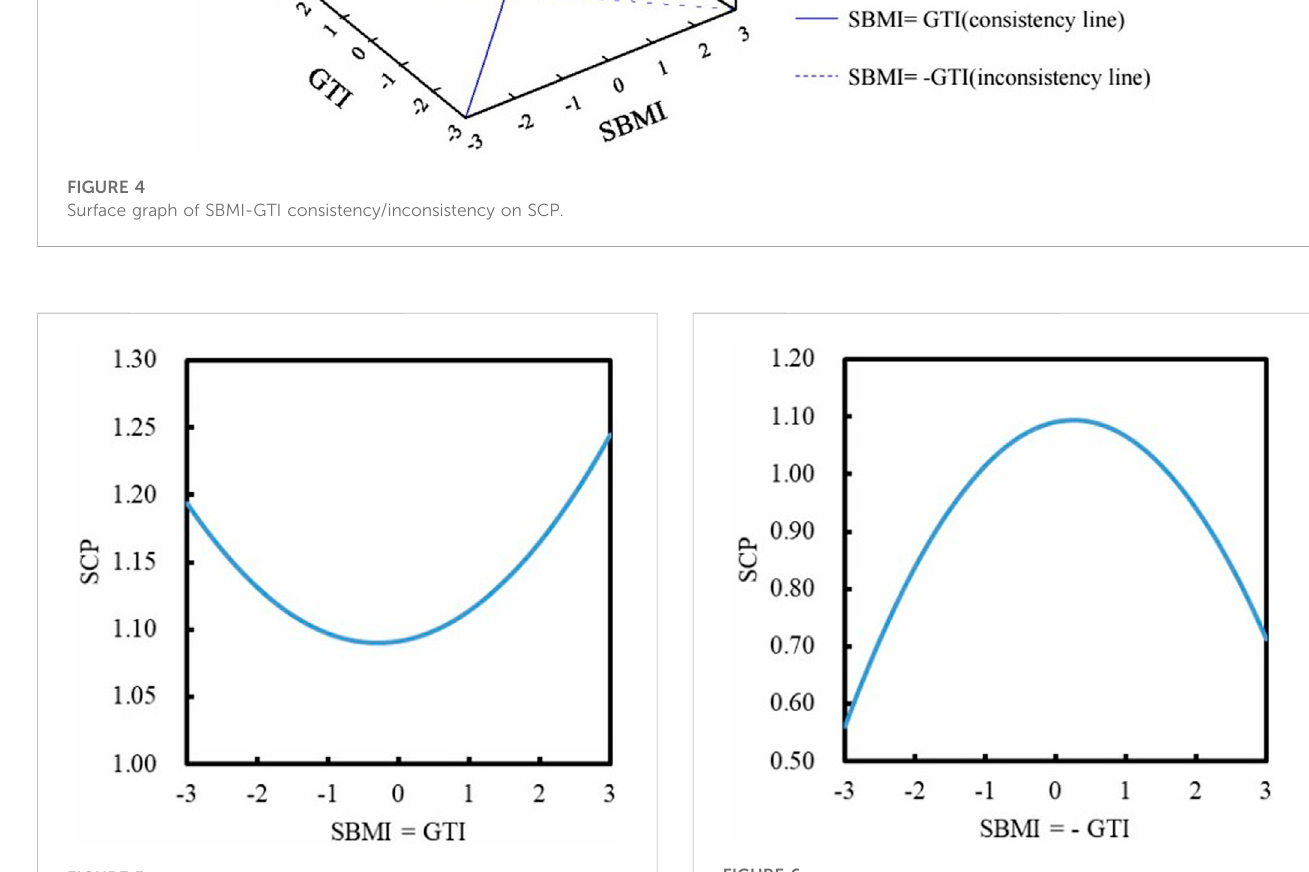
FIGURE 5 Side view of response surface along consistency line.